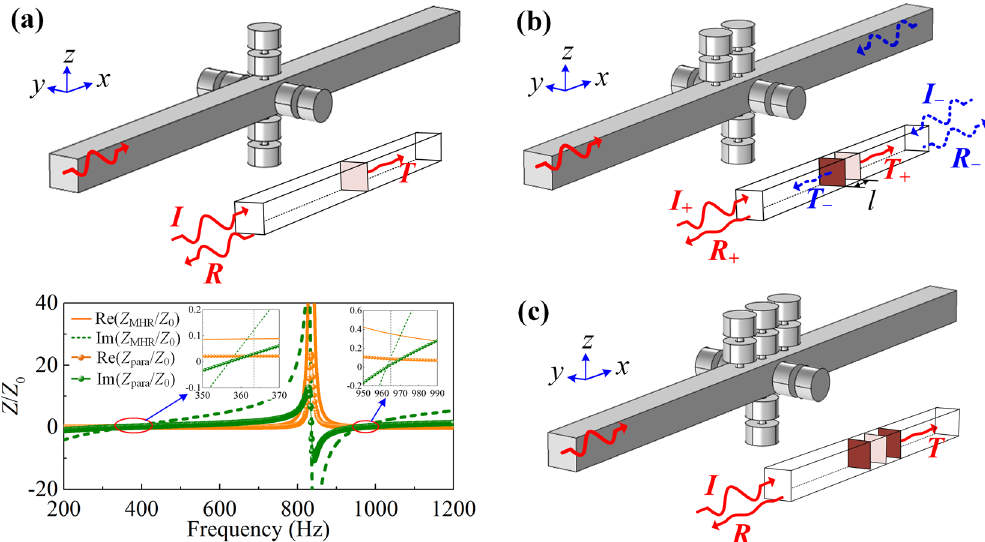
Figure 2. (a) 3D view of the artificial sound soft boundary (as sketched by the brown surface) constructed by parallel connecting four MHRs in a straight transparent tube and the impedance of the MHR ( Z MHR ) and parallel-mounted MHRs ( Z para ). (b) and (c) are corresponding for the 3D views of the asymmetric absorber and symmetric